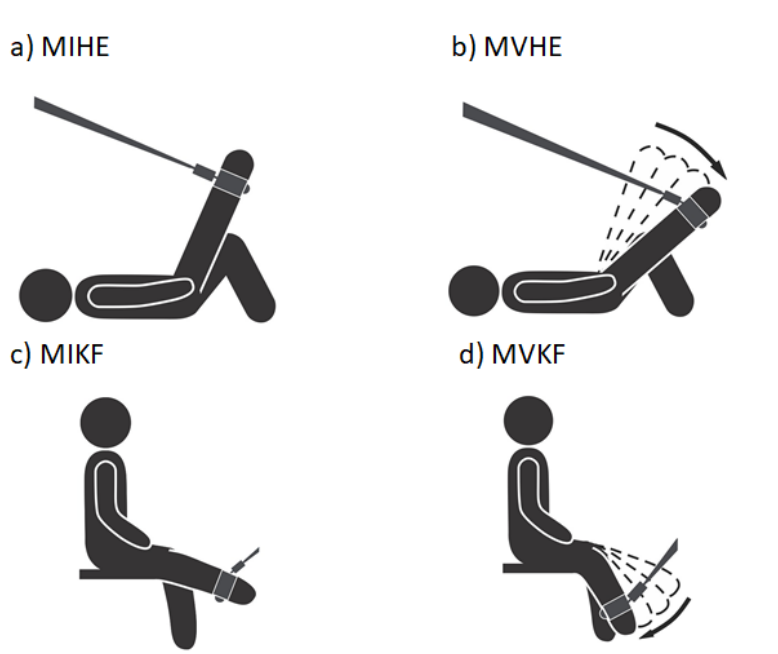
Figure 2. Motor task symbols: ( a ) the maximum isometric hip extension (MIHE) supine hamstring motor task, which also involves the gluteus maximus , acting against the rubber band held by the therapist (not shown); ( b ) the maximum velocity hip extension (MVHE); ( c ) the maximum isometric knee flexion (MIKF) sitting position hamstring motor task, which involves only the hamstring muscle; and ( d ) the maximum velocity knee flexion (MVKF), in which the athlete was asked to curl the leg with maximum velocity.